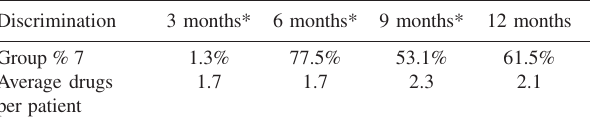
Table 1 - Consumption of medication Discrimination